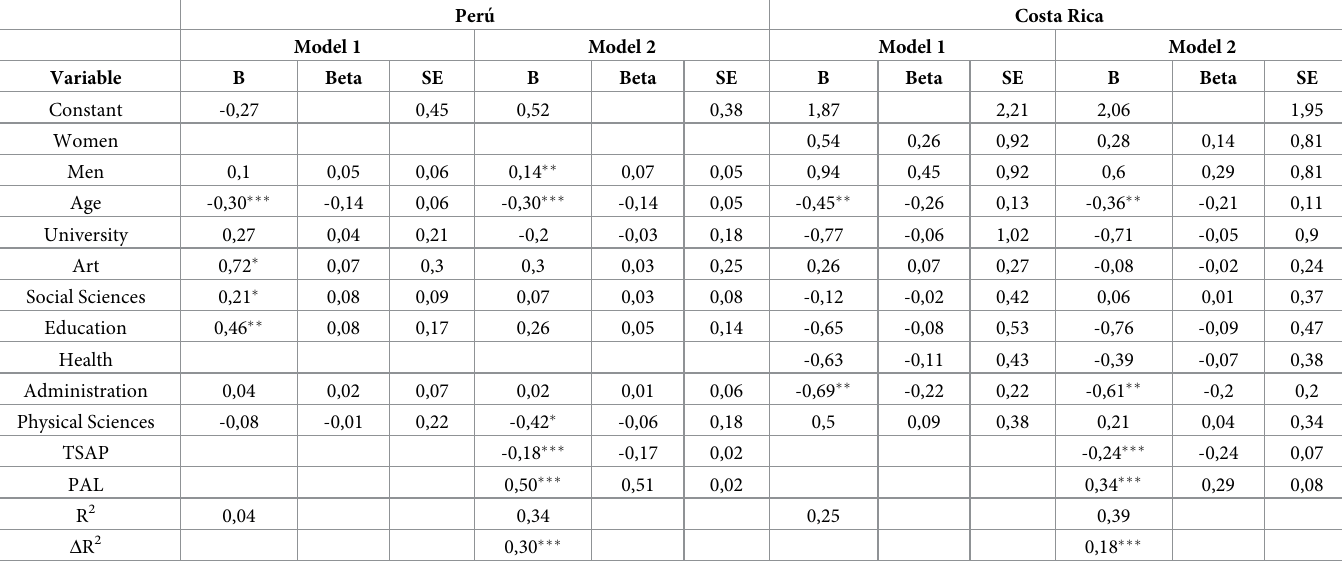
Table 7. Regression models in Peru and Costa Rica.